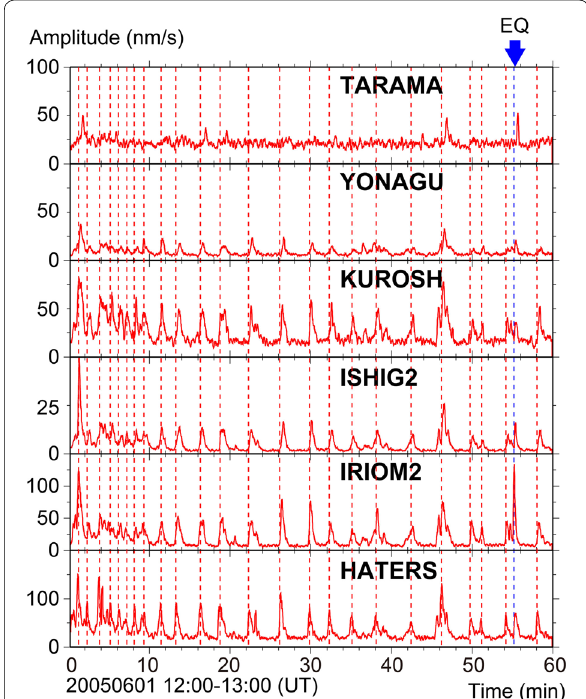
Fig. 3 Envelope waveforms at the stations in the Yaeyama area. Enve- lopes were computed using the root-mean-square (RMS) amplitude with 10-s boxcar windows and the composite horizontal components of the seismograms, which were band-pass-filtered within the range 1–2 Hz. The red dotted lines show the low-frequency earthquakes (LFEs). Blue dotted line shows the ordinary earthquake